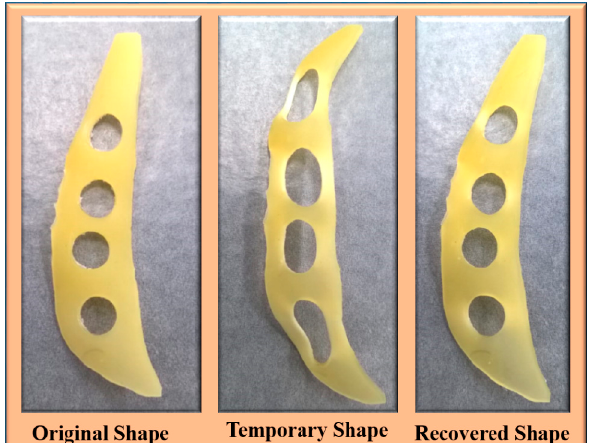
Figure 10. The shape memory ability of the prepared random shaped chitosan polyurethane composite for grip application (Temporary shape at room temperature using tensile force; recovered shape in water (wet condition) at 50 °C within 5 s).